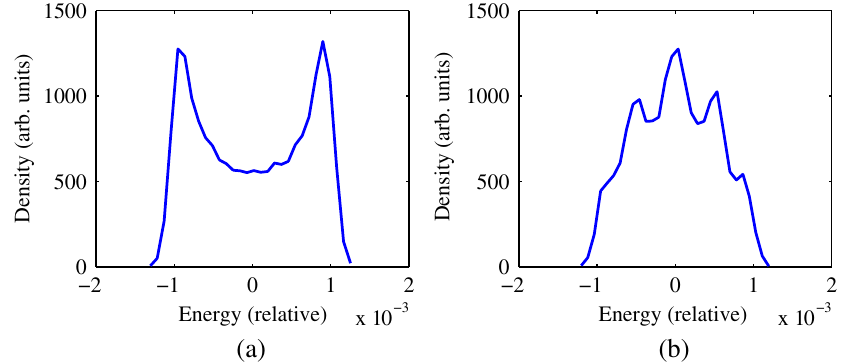
FIG. 9. Double-horn energy distribution, left, from a sinusoidal modulation. Approximating a sawtooth with two frequencies gives the more uniform energy distribution at